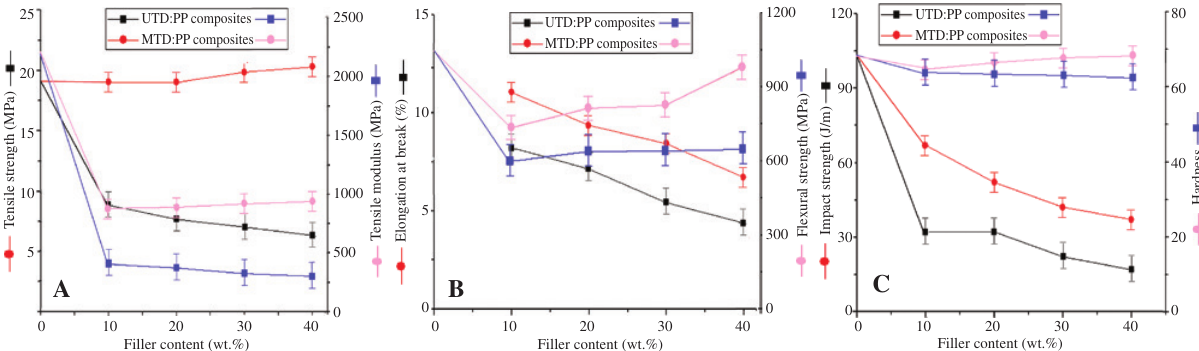
Figure 3: Mechanical properties of TD:PP composites (A) tensile strength and tensile modulus (B) elongation at break and flexural strength (C) impact strength and hardness of TD:PP